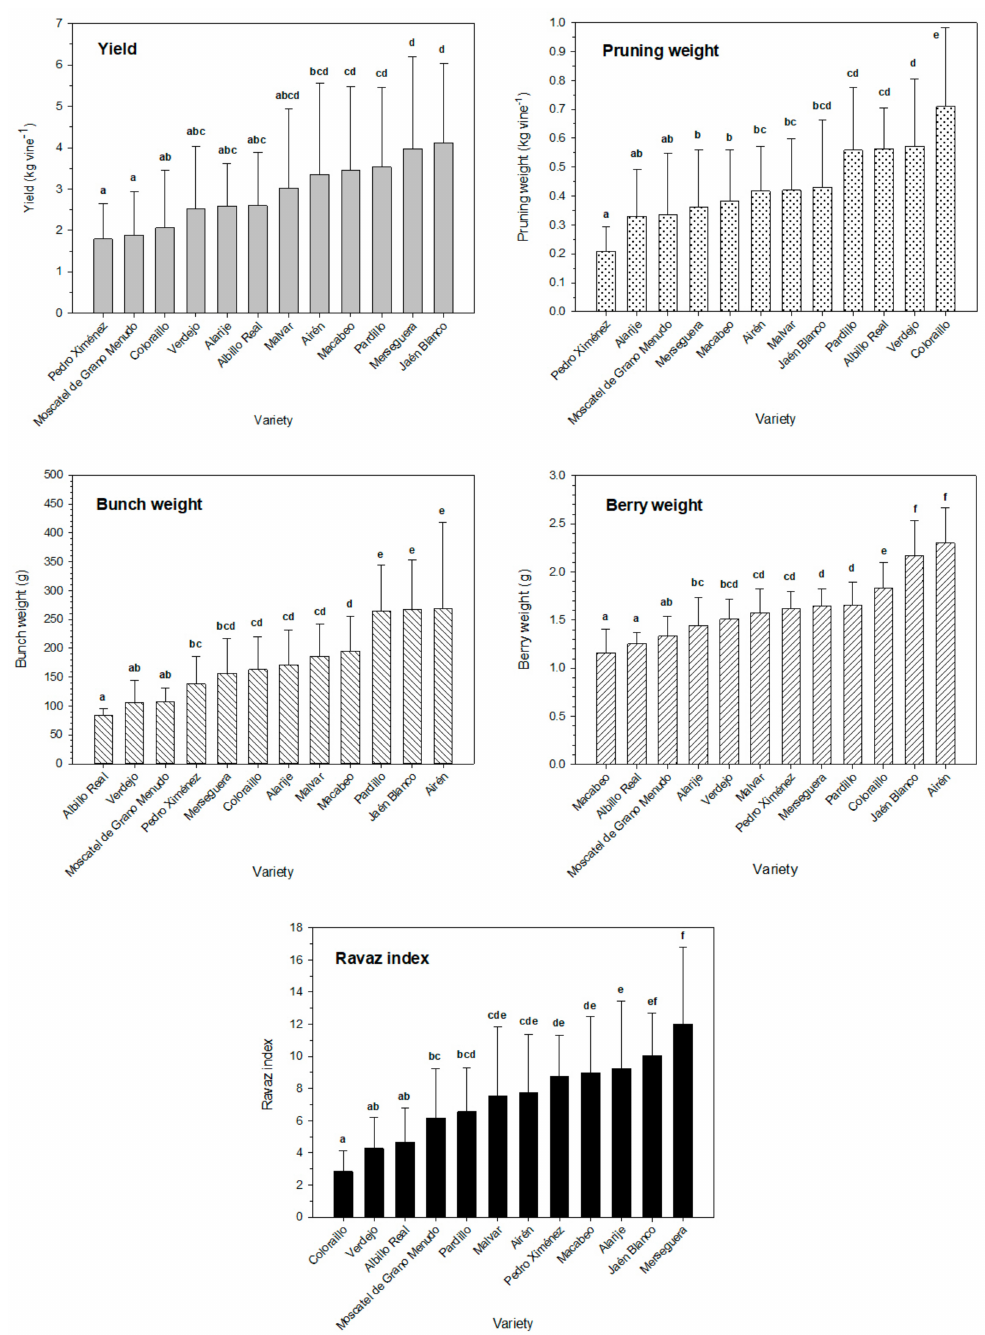
Figure 3. Yield components, pruning weight, and Ravaz index. Columns and error bars represent means and standard deviations, respectively, of 15 samples (five replicates each year). Different letters indicate statistical differences among varieties by the Duncan test (ANOVA, p <